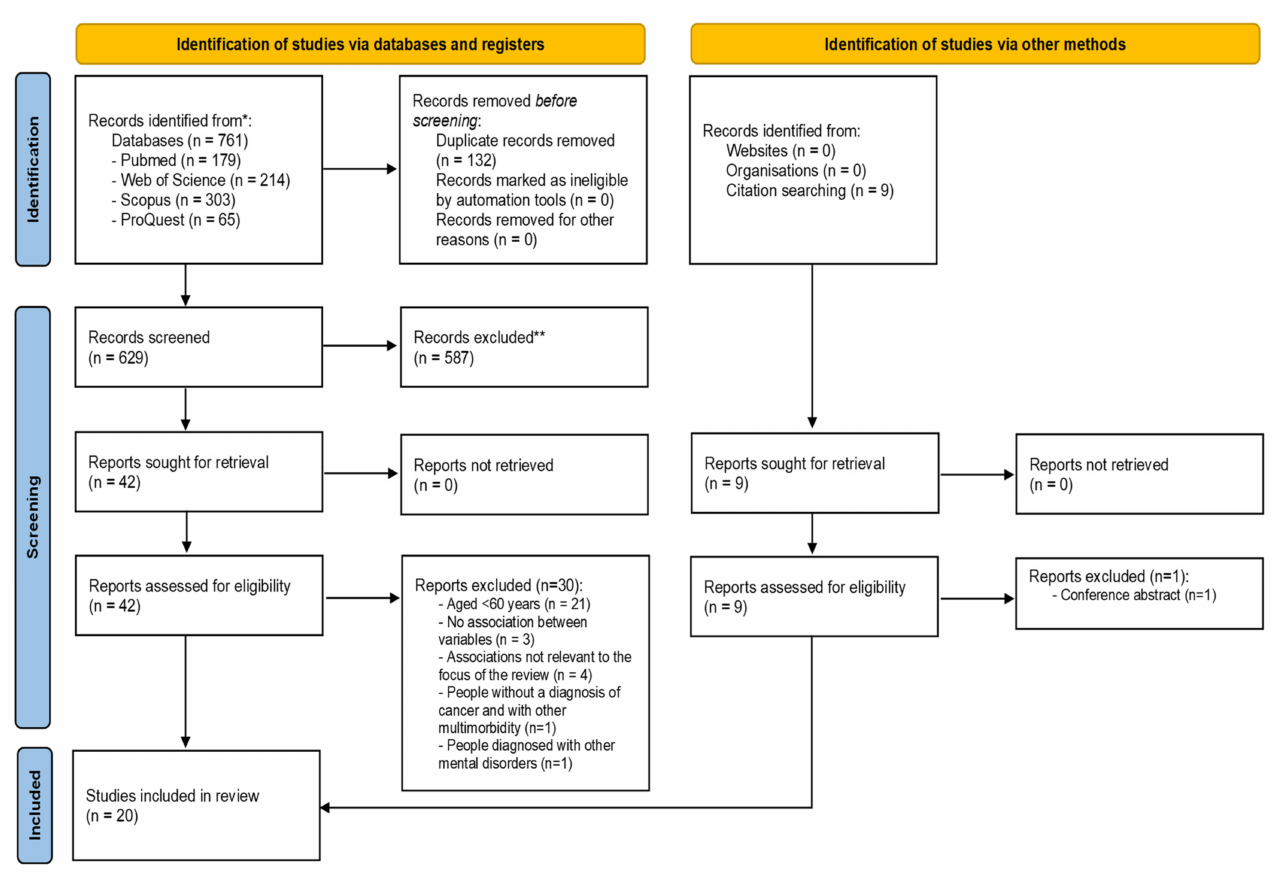
Figure 1. PRISMA flow diagram of the selection